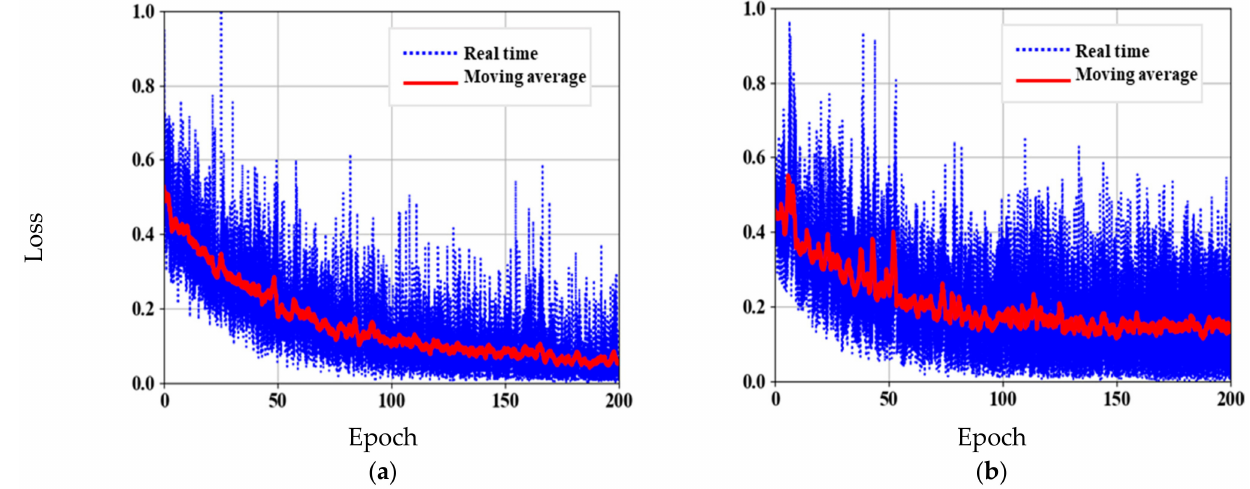
Figure 5. Skeleton network pre-training: ( a ) Training loss curve; ( b ) Validation loss curve. The same data augmentation criteria are performed as that of skeleton network pre- training. The parameters of ResNet34 are loaded, and parameters of DeeperLabC model are adjusted and optimized using Adam optimizer. Keeping the same learning rate, the network took about 5 h to train with 150 epochs and a batch size of 16. The loss curves of DeeperLabC model are shown in Figure 6.